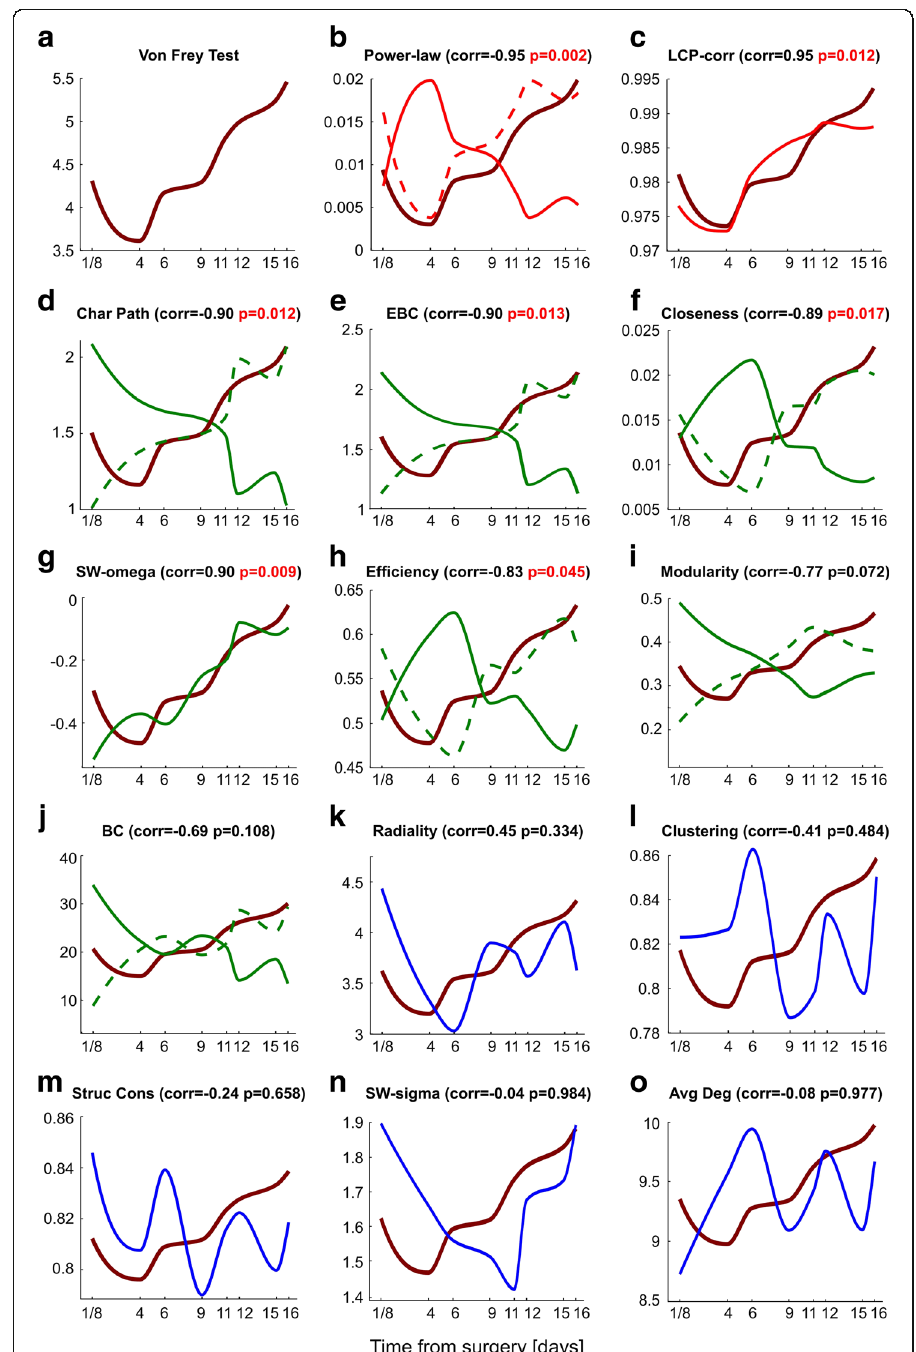
Fig. 3 (See legend on next